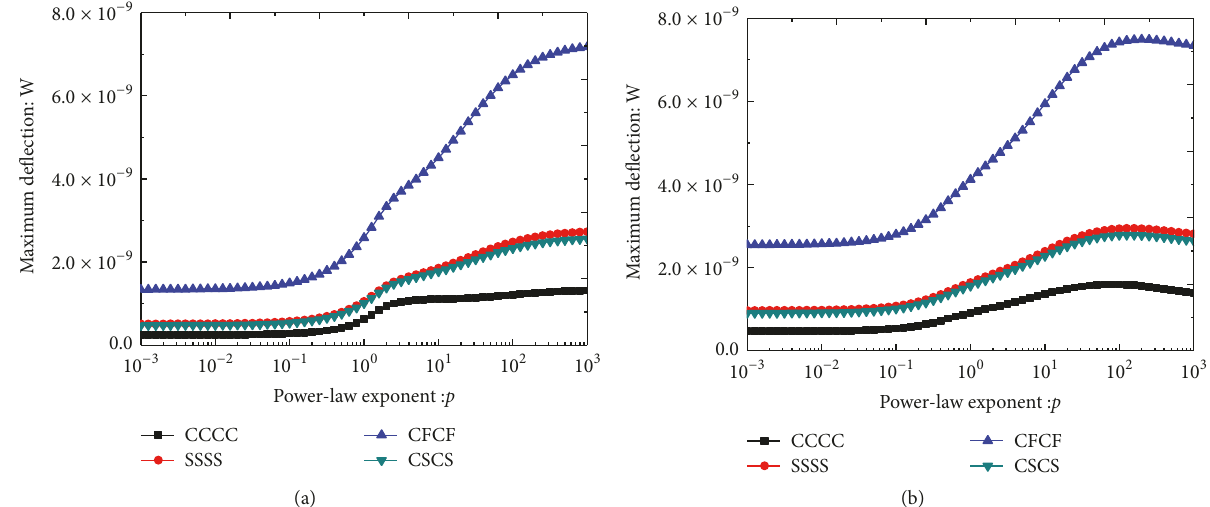
Figure 4: Variation of the static deflection versus the power-law exponent 𝑝 for FG plate with central point load: (a) Al/Al 2 O 3 plate; (b) Al/ZrO 2 plate.